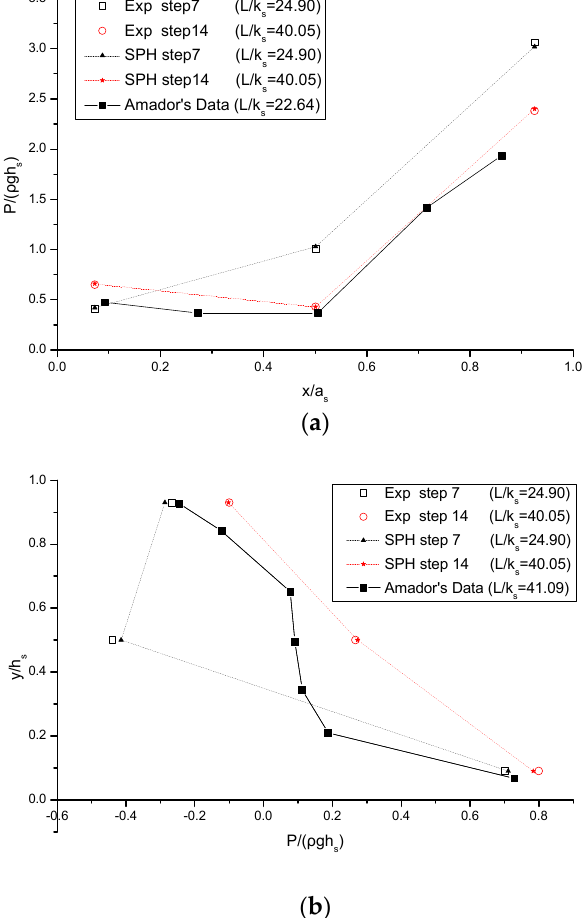
Figure 10. Pressure distributions on: ( a ) Horizontal; ( b ) Vertical step faces, for the 31-step spillway case.